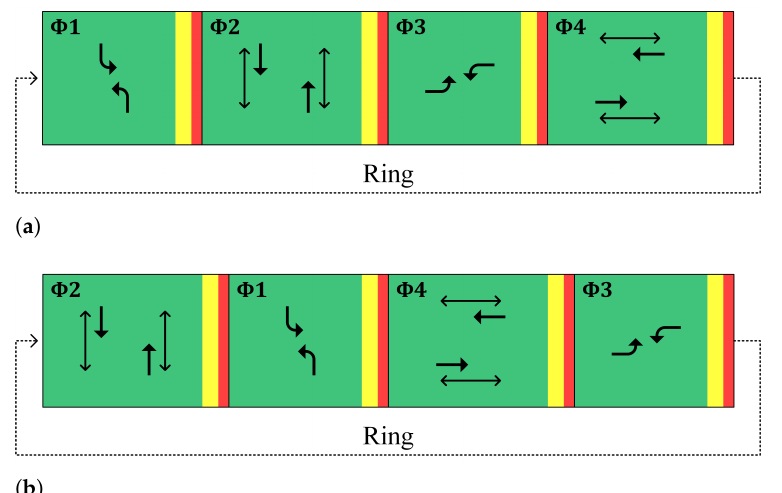
Figure 1. Common options for the single-ring phasing. Φ represents vehicle phase number, solid one- way arrows represent protected vehicle movements, and Solid two-way arrows represent pedestrian movements. Subfigure ( a ) shows the leading left-turn phasing, and ( b ) the lagging left-turn